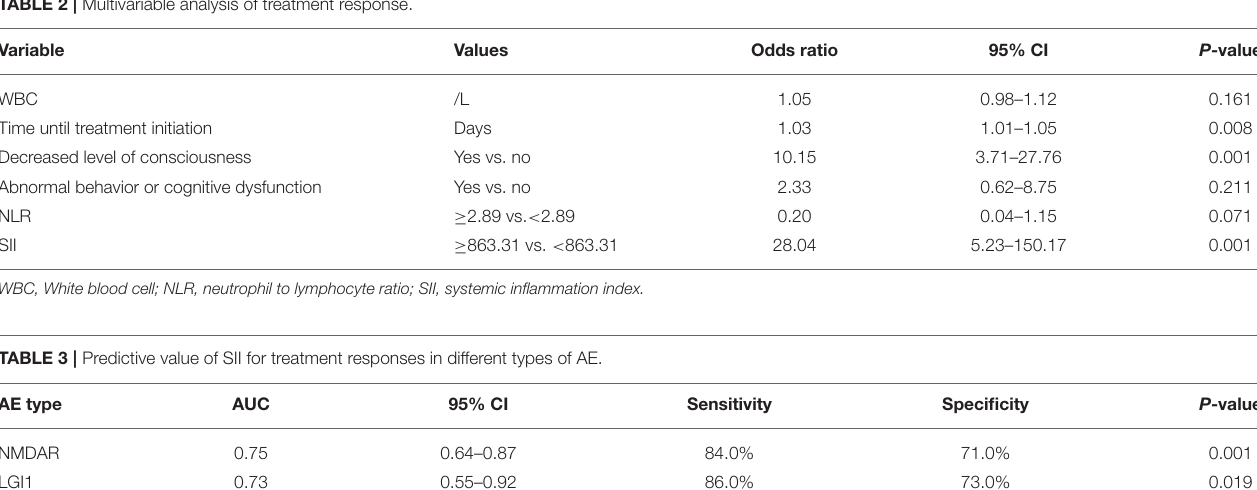
TABLE 2 | Multivariable analysis of treatment response.